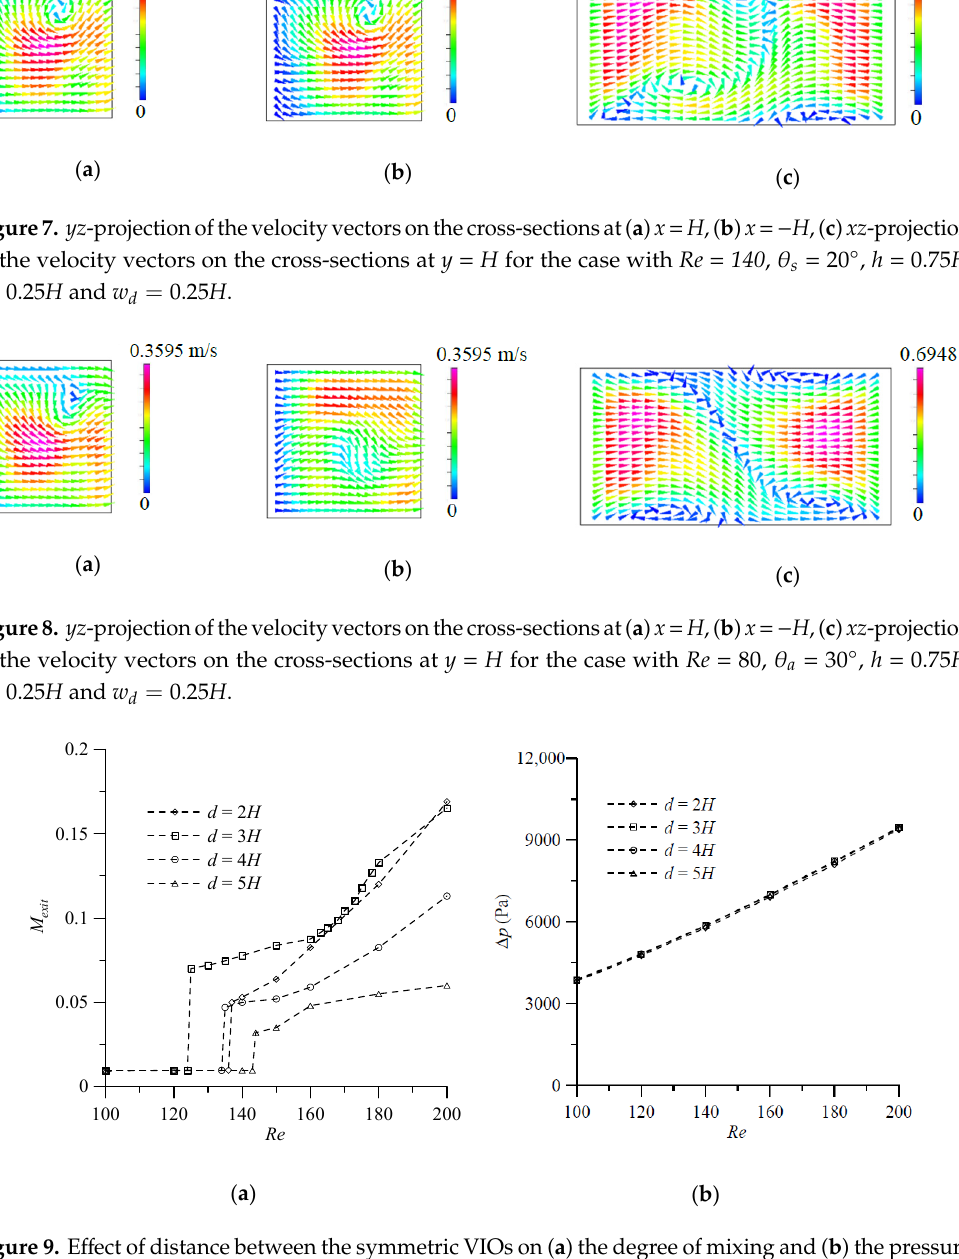
Figure 9. E ff ect of distance between the symmetric VIOs on ( a ) the degree of mixing and ( b ) the pressure drop in the mixers with θ s = 20 ◦ , h = 0.75 H , t = 0.25 H and w d = 0.25 H for various Reynolds numbers.